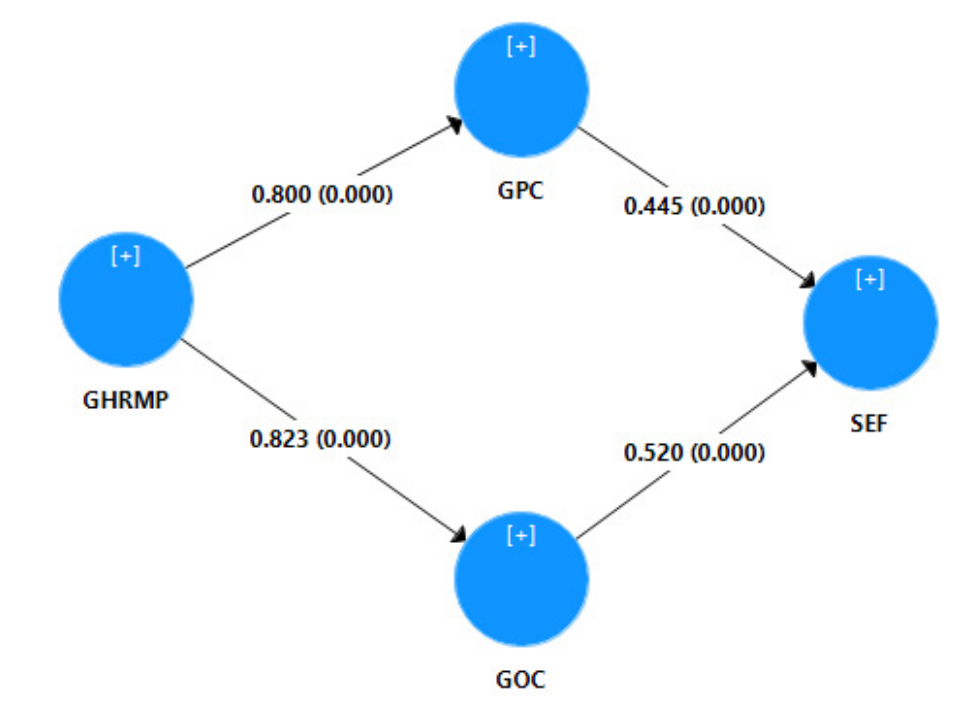
Table 7. Mediator analysis.